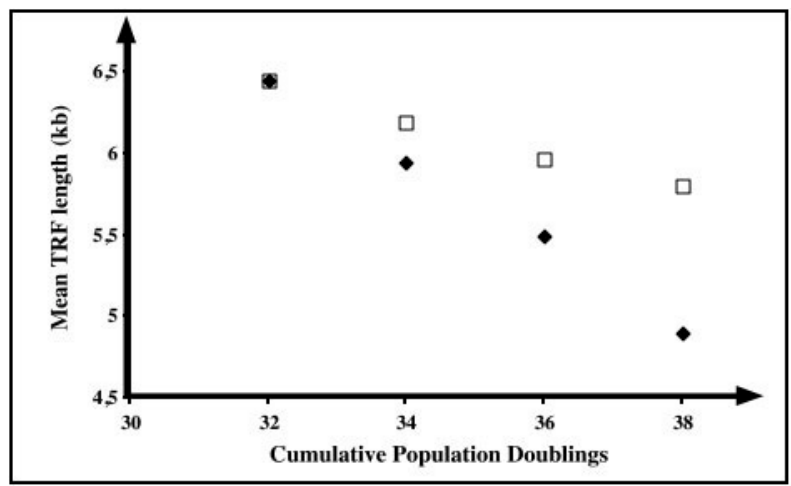
FIGURE 3. Effect of repeated t-BHP stress with a stress at every 2 CPDs on telomere shortening in WI-38 HDFs. At every 2 CPDs, the confluent cells were exposed to a subcytotoxic 1-h stress under 100 µM t-BHP. After 48 h of recovery, the cells were plated at 1:4. When confluence was reached, half of the cultures were used for measurement of TRF length while the other half were exposed to a further stress. Four stresses were sufficient to reach growth arrest in the stressed cultures. WI-38 HDFs exposed to t-BHP ( ♦) ; Control WI-38 HDFs (open